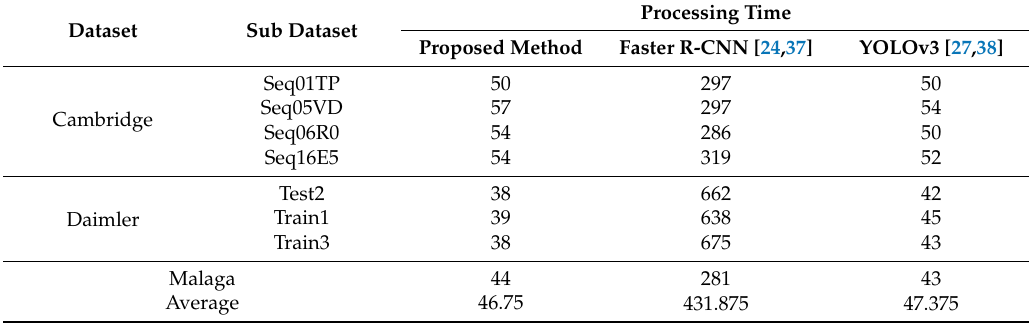
Table 11. Processing time per each frame on Jetson TX2 embedded system (unit: